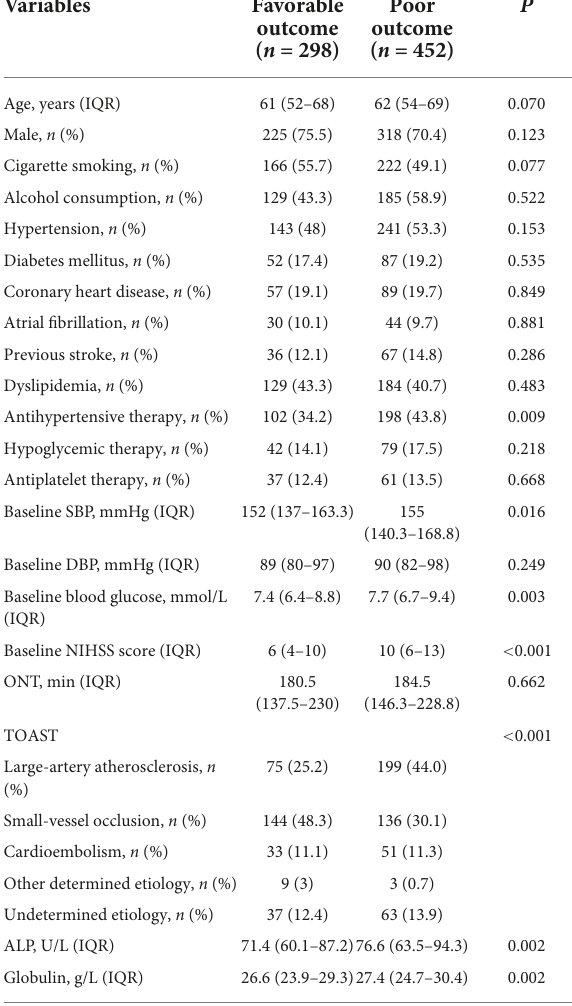
TABLE 4 Clinical characteristics of patients in favorable outcome and poor outcome.